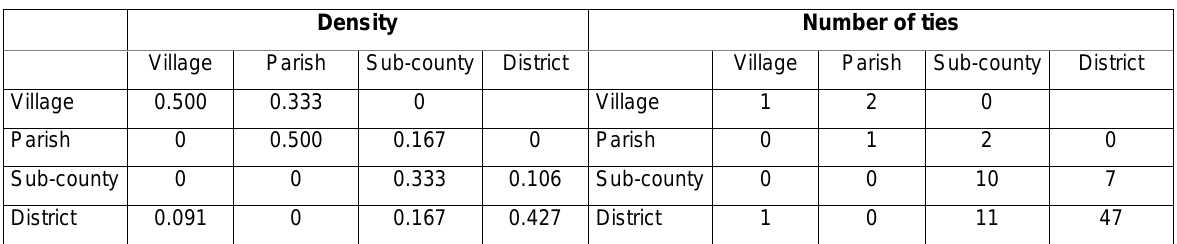
Table 4: Intensity of information exchange between different tiers of the local governance system